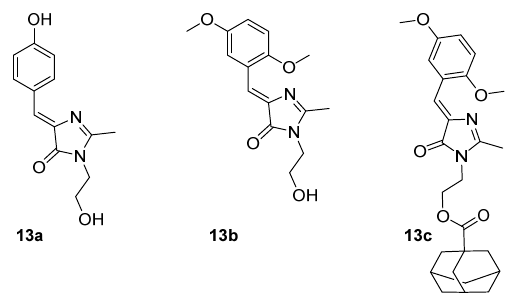
Figure 13. GFPc analogues used to study the supramolecular interaction with cyclodextrin [27]. In a similar approach, the inner surface of the Tobacco Mosaic Virus (TMV) has been used to mimic the GFP β -barrel, as they are quite similar. Chromophore 14 (Figure 14) could be easily conjugated to the glutamate residues of the TMV channel through its amino group. After conjugation, the fluorescence intensity of TMV- 14 exhibited a significant enhancement when compared to the isolated GFPc 14 , with an extra enhancement in the presence of different organic solvents, with DMSO being the one that showed the most dramatic results [28].